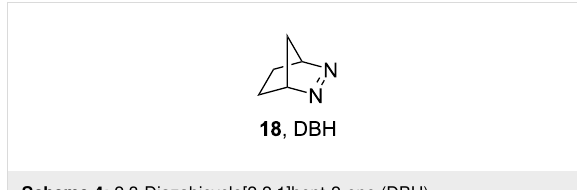
Scheme 2: Proposed radical pair formation after the photolysis of benzaldehyde ( 8 ).